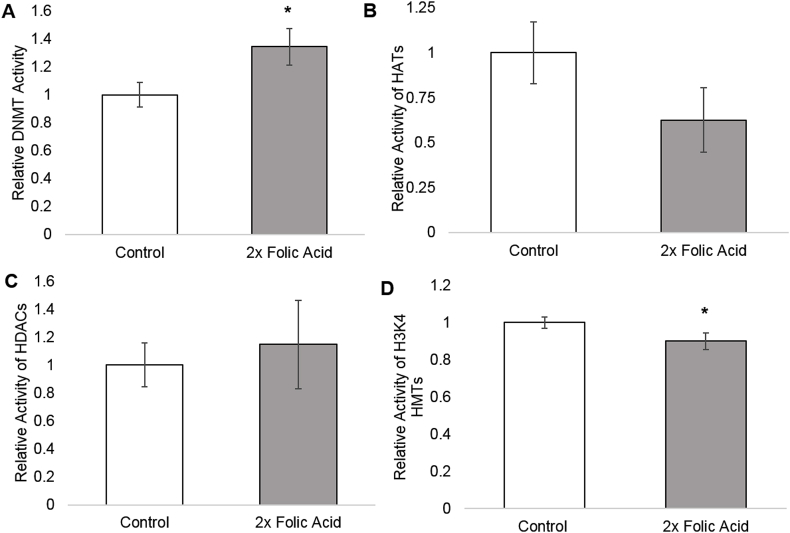
A. Relative DNMT Activity as measured by ELISA assay for control and 2x FA treated SHSY5Y cells; p = 0.046. B. Relative HAT Activity as measured by ELISA assay for control and 2x FA treated SHSY5Y cells; p = 0.084. C. Relative HDAC Activity as measured by ELISA assay for control and 2x FA treated SHSY5Y cells; p = 0.31. D. Relative H3K4 HMT Activity as measured by ELISA assay for control and 2x FA treated SHSY5Y cells; p = 0.048. For each assay, three replicates were tested per treatment group. All Fig. 2 error bars are ± 1 standard deviation. A single asterisk (*) indicates p < 0.05 using a paired two-tailed t-test.